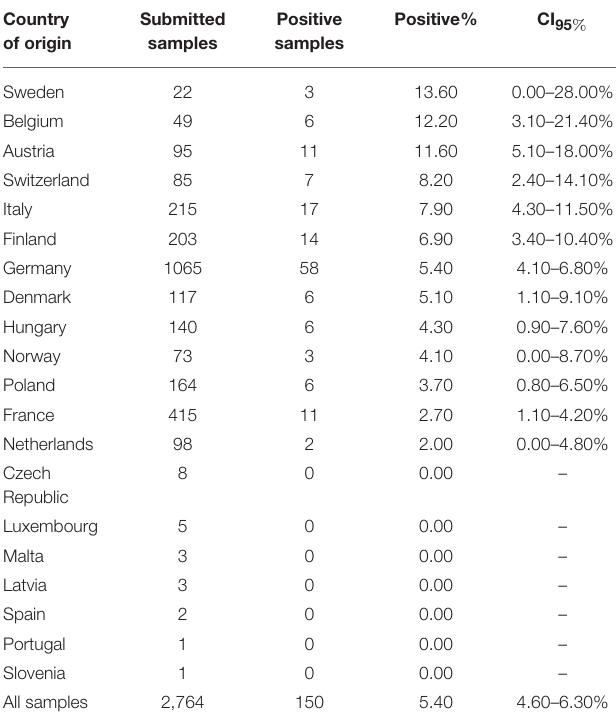
TABLE 3 | Submitted samples for B. canis antibody testing: Country of origin, positivity and confidence intervals (CI 95 % ). Country of origin